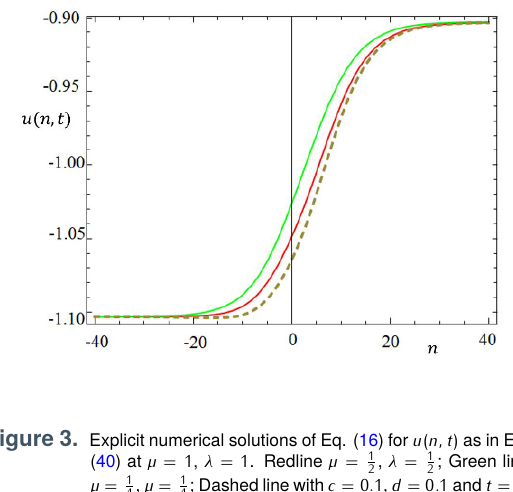
( n,t ) as in Eq. , λ = 1 ; Green line 2 2